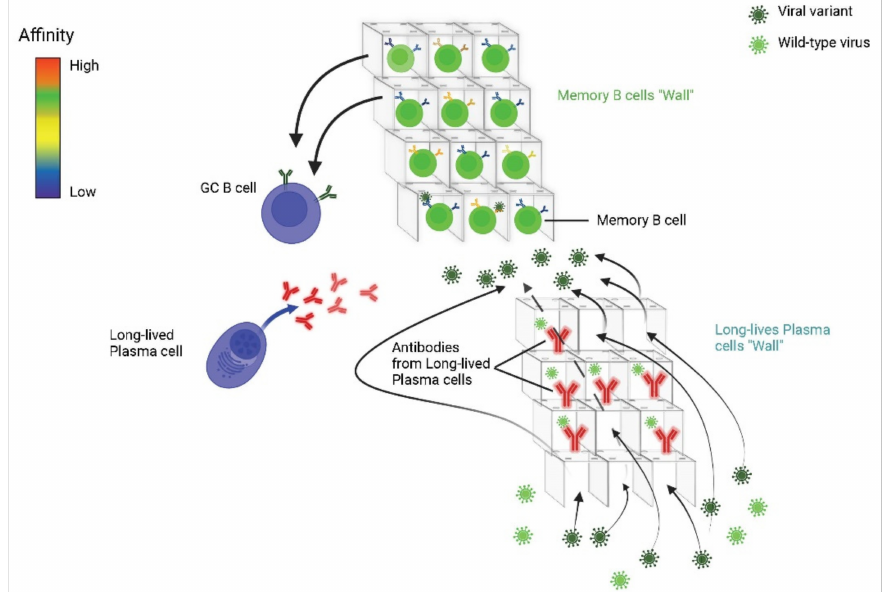
Figure 3. Humoral immunity naturally produces memory B cells and antibodies that also recognize viral variants. The long-lived plasma cells in the bone marrow secrete highly selected antibodies, specific and related to the first form selected. They are specific to the encountered pathogen (repre- sented in red) and are against the relative infection. Variant pathogens (e.g., other viruses) can find “holes” in this barrier; however they may encounter a second barrier made up by memory B cells that were less selected. This happens because memory B cells retain a wider range of antigenic affinity and adaptability. Memory B lymphocytes are activated by the different variants; in this case, they either differentiate into long-lived plasma cells or to return to the germinal centers (GCs) in order to replenich the pool of memory B